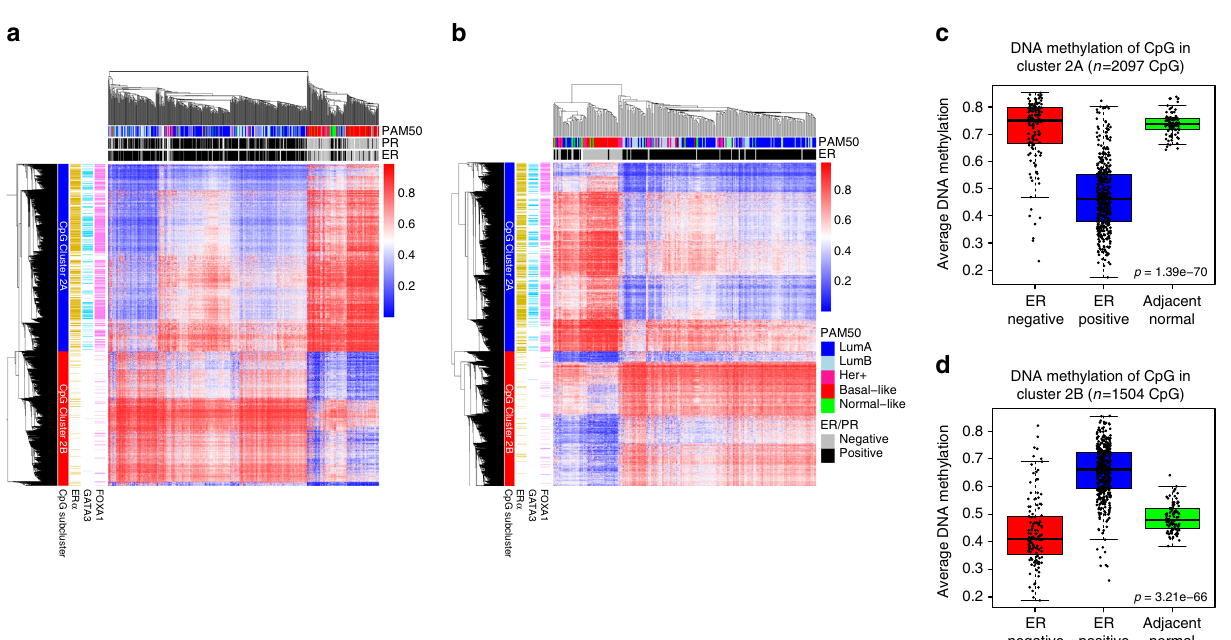
Fig. 3 Differential DNA methylation of Cluster 2 CpGs in TF binding regions. Unsupervised clustering of DNA methylation levels of the CpGs in Cluster 2 for ( a ) the TCGA cohort ( N = 609) and ( b ) the OSL2 cohort ( N = 272). Annotation of the rows of the heatmap shows whether a CpG is located in ER α ( yellow ), FOXA1 ( pink ) or GATA3 ( light blue ) binding regions according to ChIP-seq experiments in MCF7 cells. Annotations of the column of the heatmap indicate histopathological features of the patients: PAM50 subtype, ER and PR status. c – d Average DNA methylation of c the 2097 CpGs in Cluster 2A and D) 1504 CpGs in Cluster 2B for samples in the TCGA cohort. Boxplots represent the average DNA methylation of these CpGs in ER positive ( blue ; n = 418), ER-negative tumors ( red ; n = 124) and adjacent normal tissue ( green ; n = 97). Kruskal-Wallis test p -values are